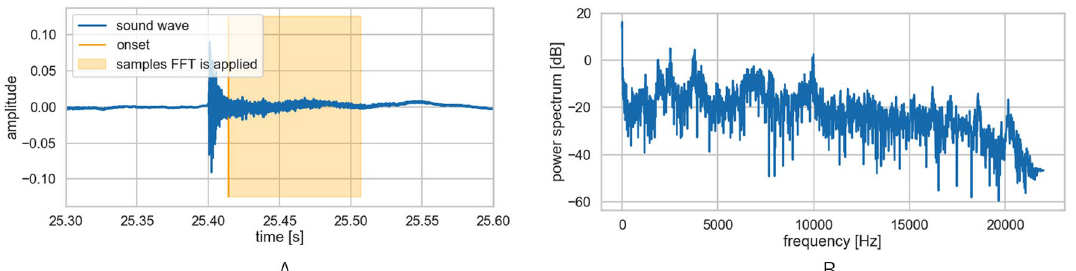
Figure 2. Signal extraction of the hammering sound. Step 1; Automatic detection of the signals of the hammering sound using the python library of the voice processing system (Librosa) (2A). Step 2; Every automatically detected sound was reviewed by a human, and all sounds other than the hammering sound were deleted manually (2B).